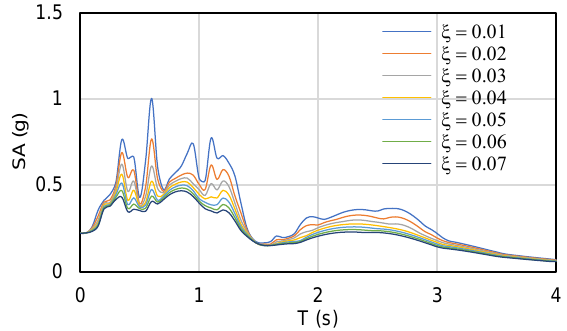
Figure 9. Ground surface SA of the TE waveform.